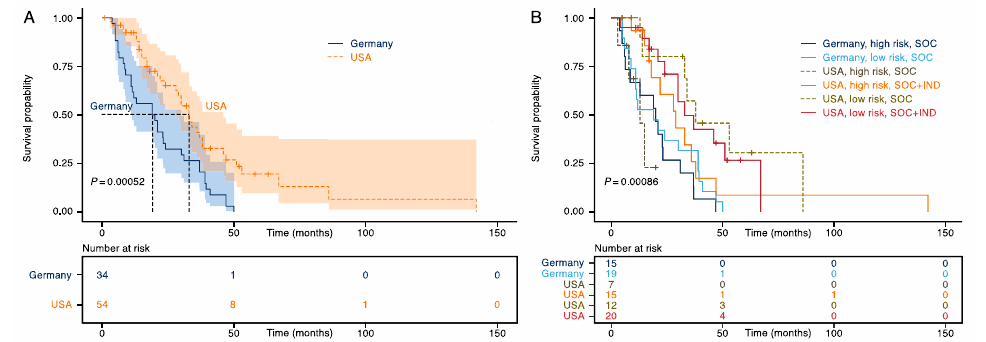
Figure 1. Kaplan–Meier estimates for stage IV colorectal cancer patients according to country and treatment regimens. ( A ) Patients in America diagnosed in 2008–2017 had a median survival probability of 33 months, compared to 19.5 months in patients in Germany diagnosed in 2003–2010. Shading indicates 95% confidence intervals. ( B ) Kaplan–Meier curves stratified by country, standard of care (SOC), and SOC, followed by individualized treatments (SOC + IND), and mutational high risk (Schell classes 0 and 4) vs. low risk (Schell classes 1–3). NB: The American SOC between 2008 and 2017 was more individualized than the German SOC between 2003 and 2010.